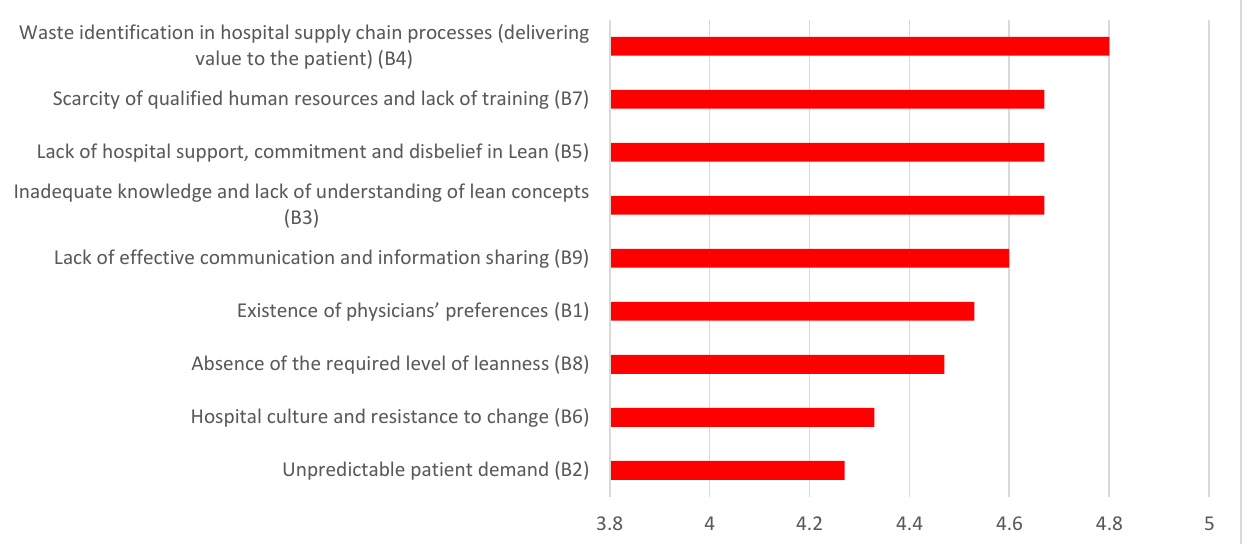
Figure 5. Effectiveness of proposed solutions for overcoming lean barriers.